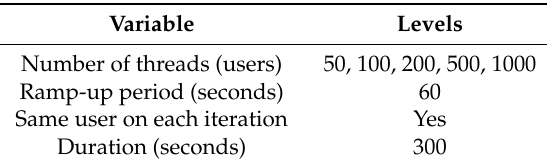
Table 1. Experimental